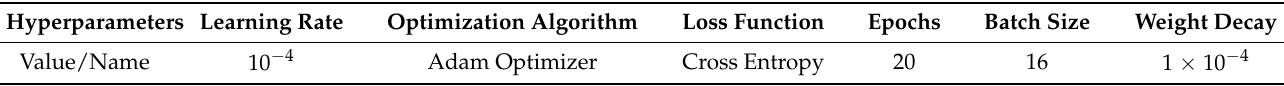
Table 1. Hyperparameters of the GoogleNet and Resnet34 model. Hyperparameters Learning Rate Optimization